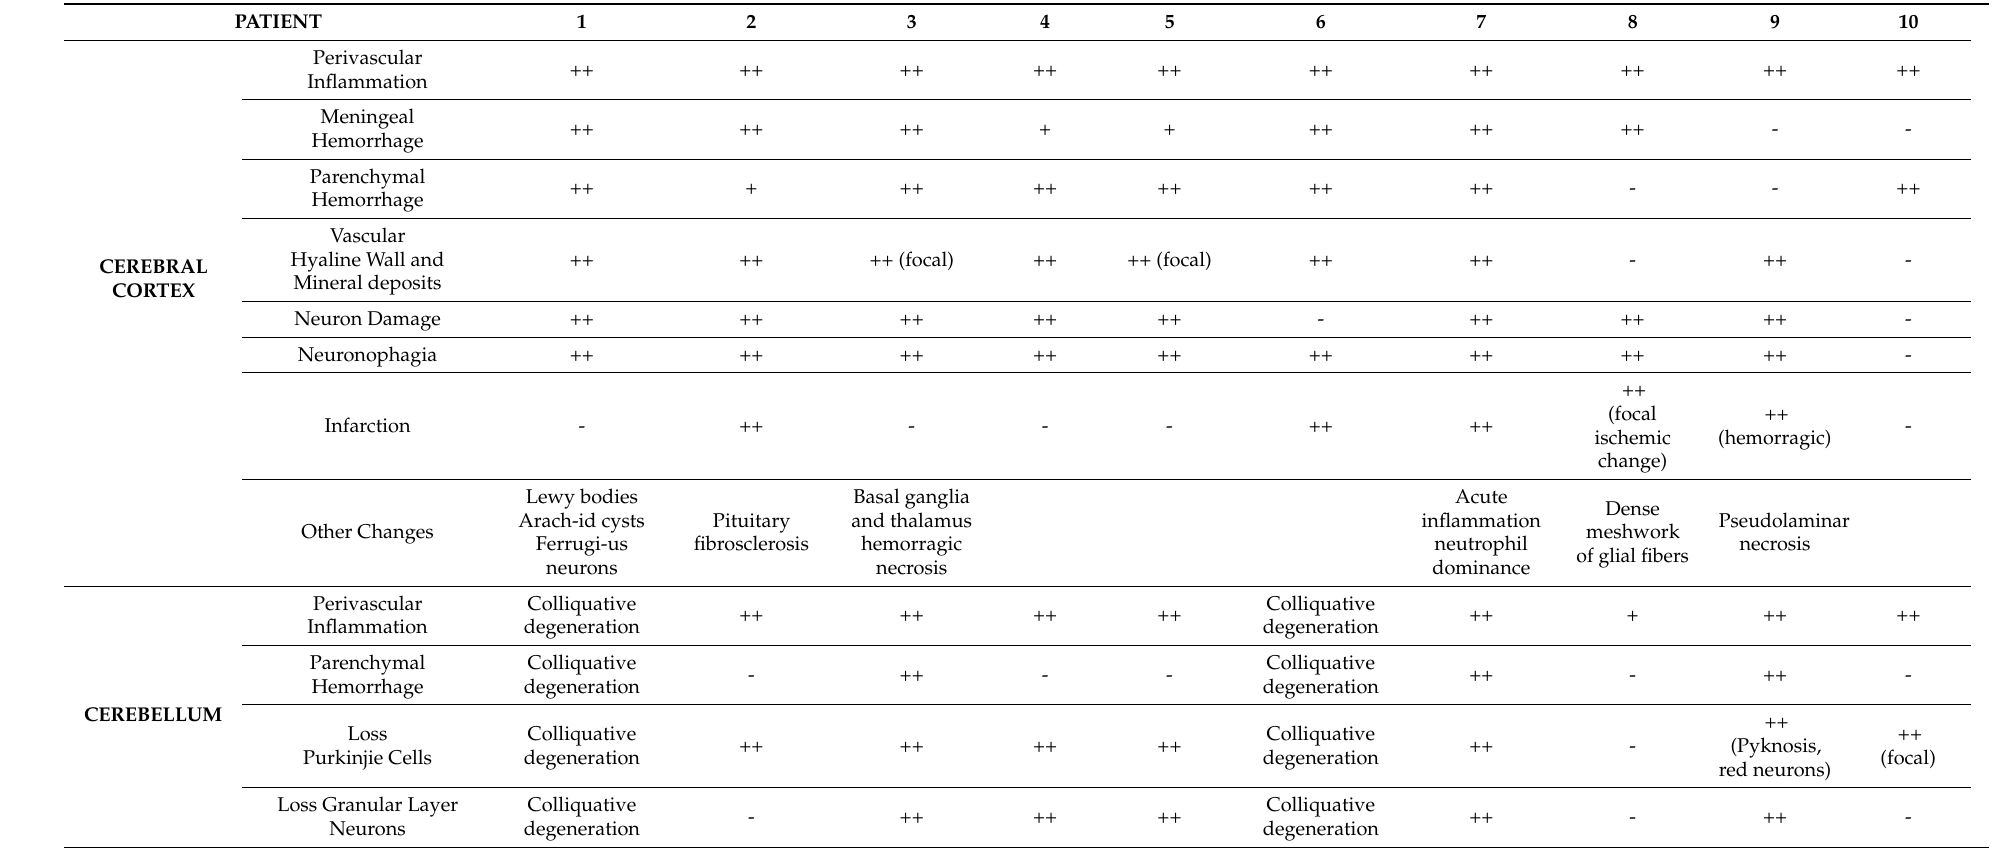
Table 3. Histopathological